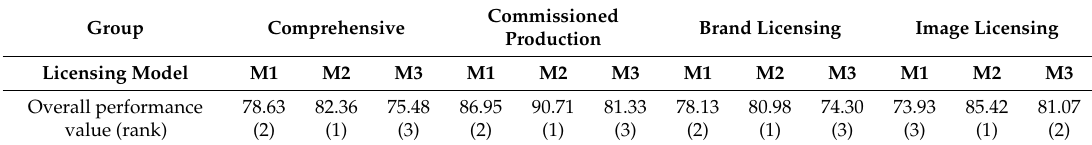
Table 6. Overall performance values across